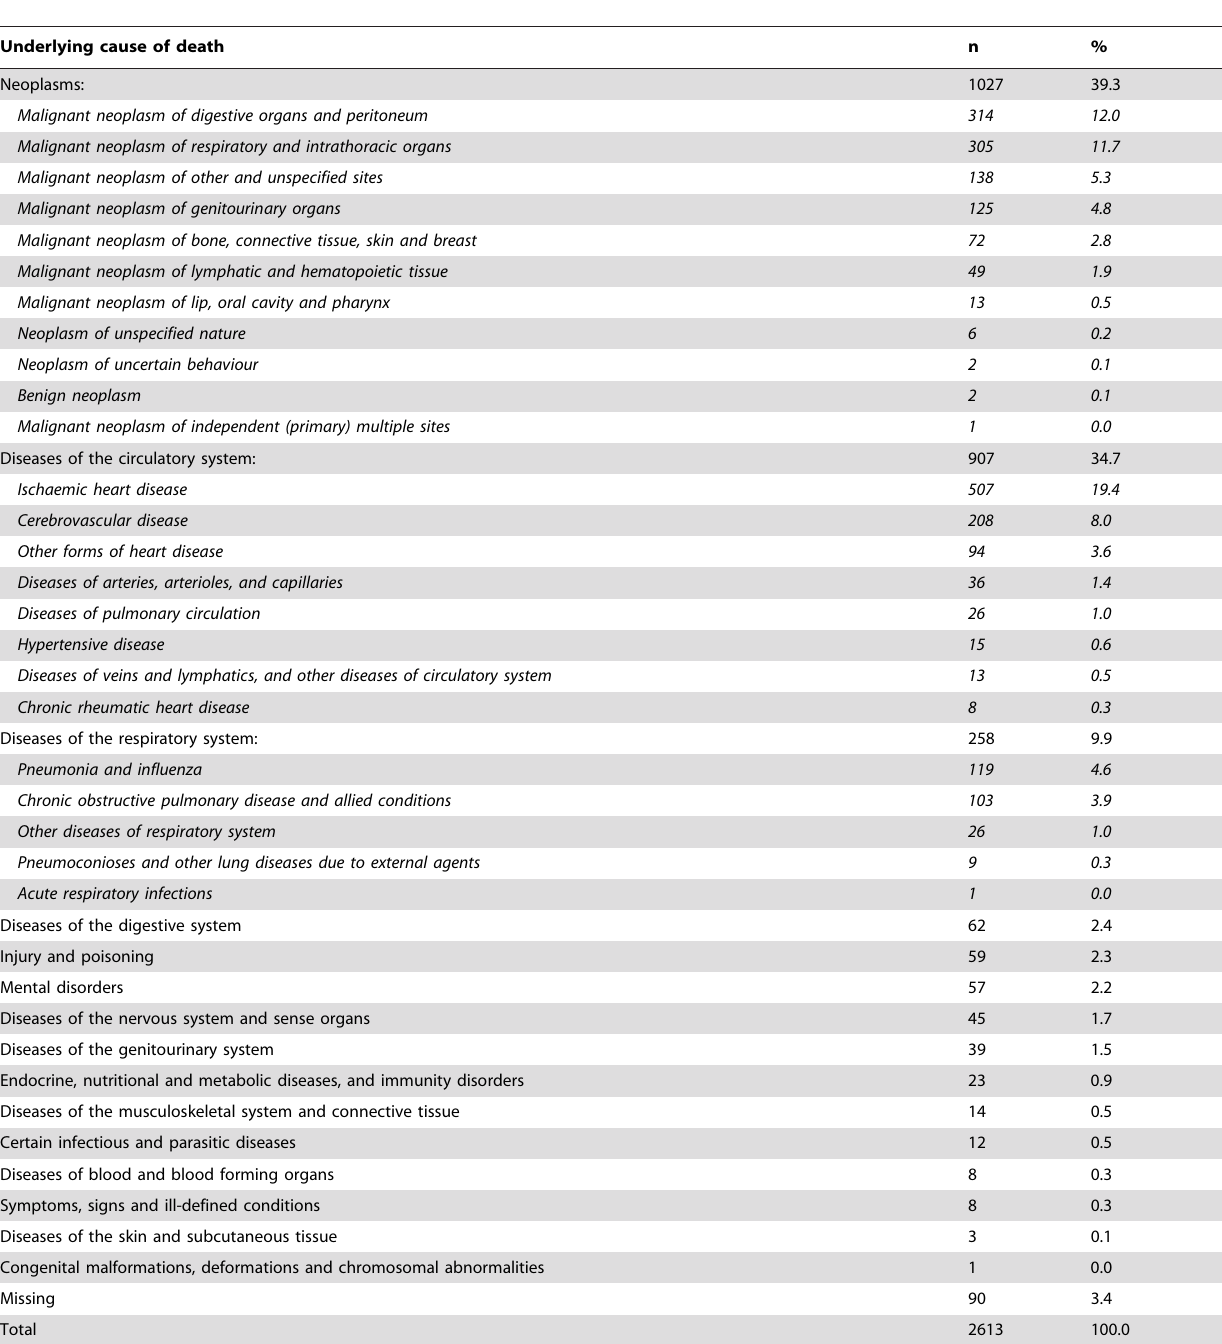
Table 2. Causes of mortality within one year of liver function